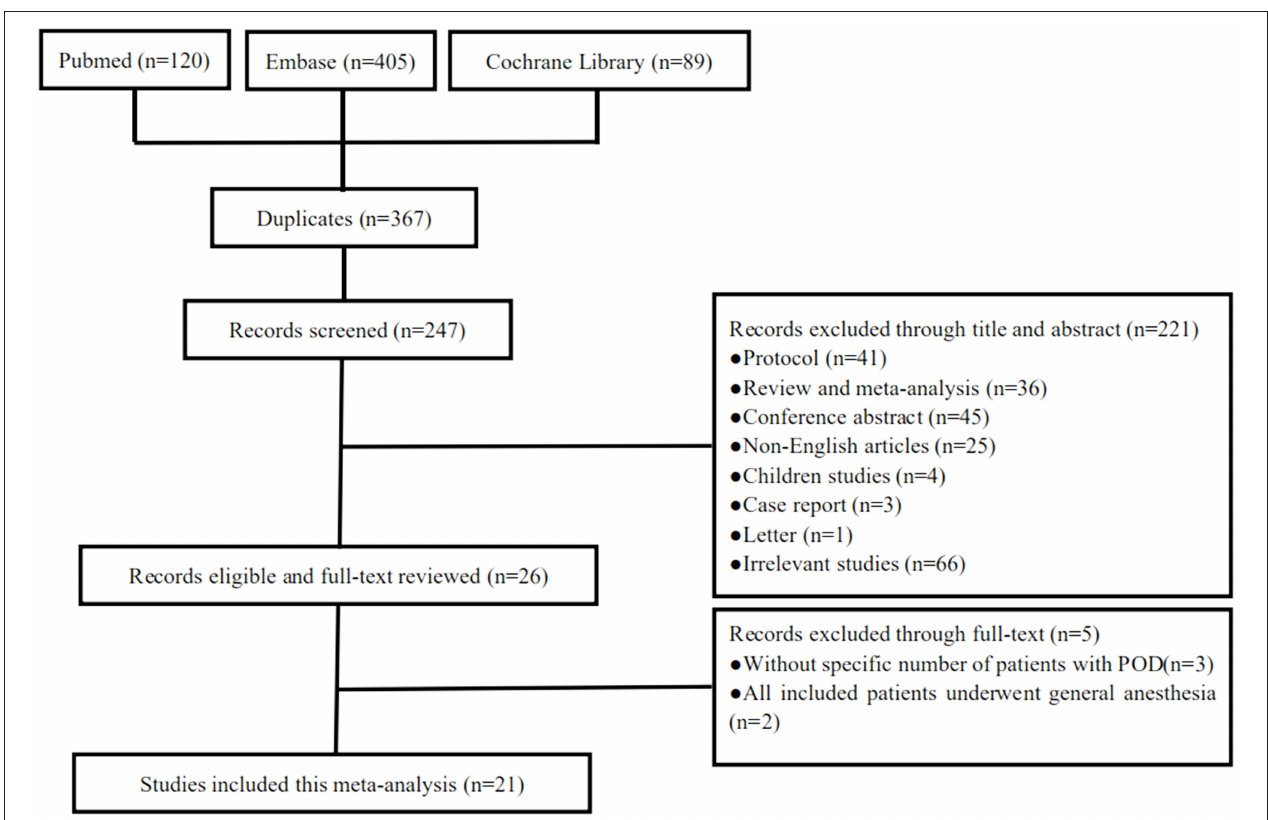
FIGURE 1 | The screening process of the eligible